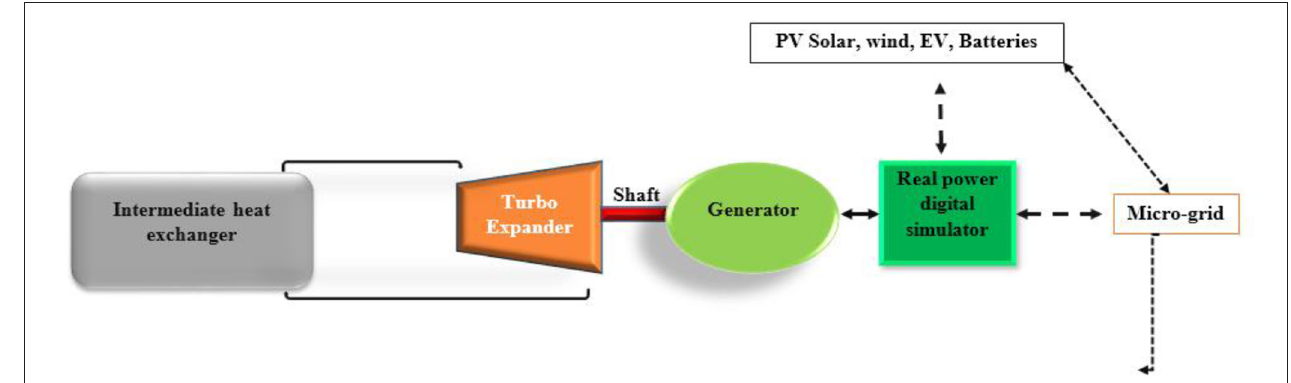
FIGURE 7 | Schematic of mechanical